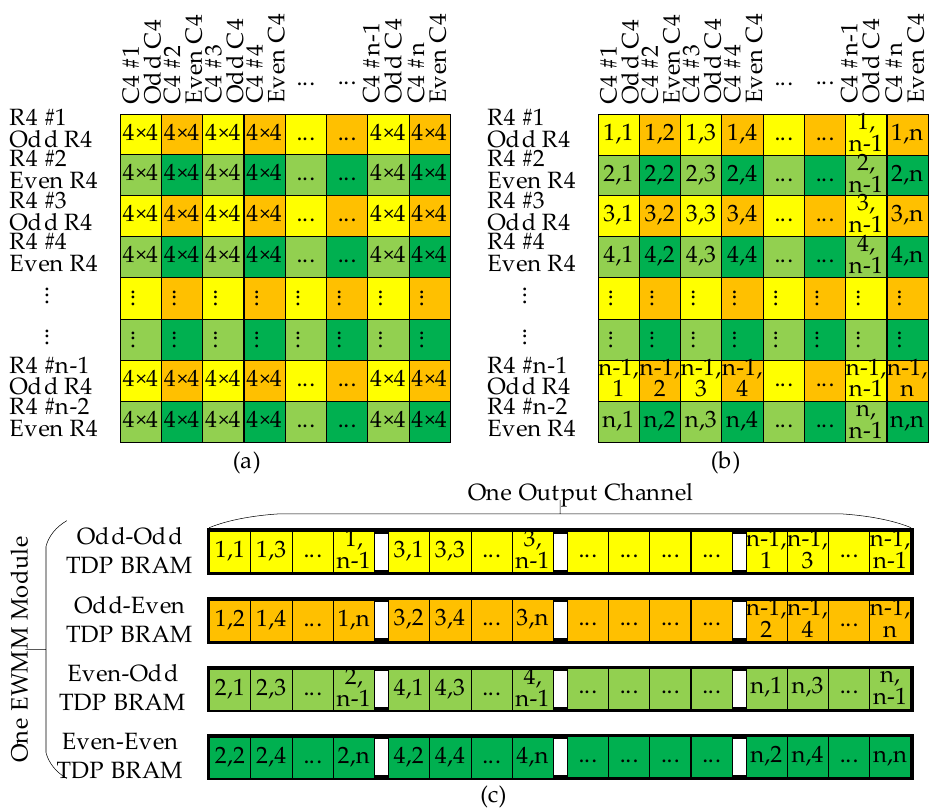
Figure 7. Ping-pong BRAM implemented by multi-mode BRAM: ( a ) OFM is divided into several 4 × 4 parts; ( b ) each 4 × 4 part has a coordinator; ( c ) Four BRAMs store all 4 × 4 parts of